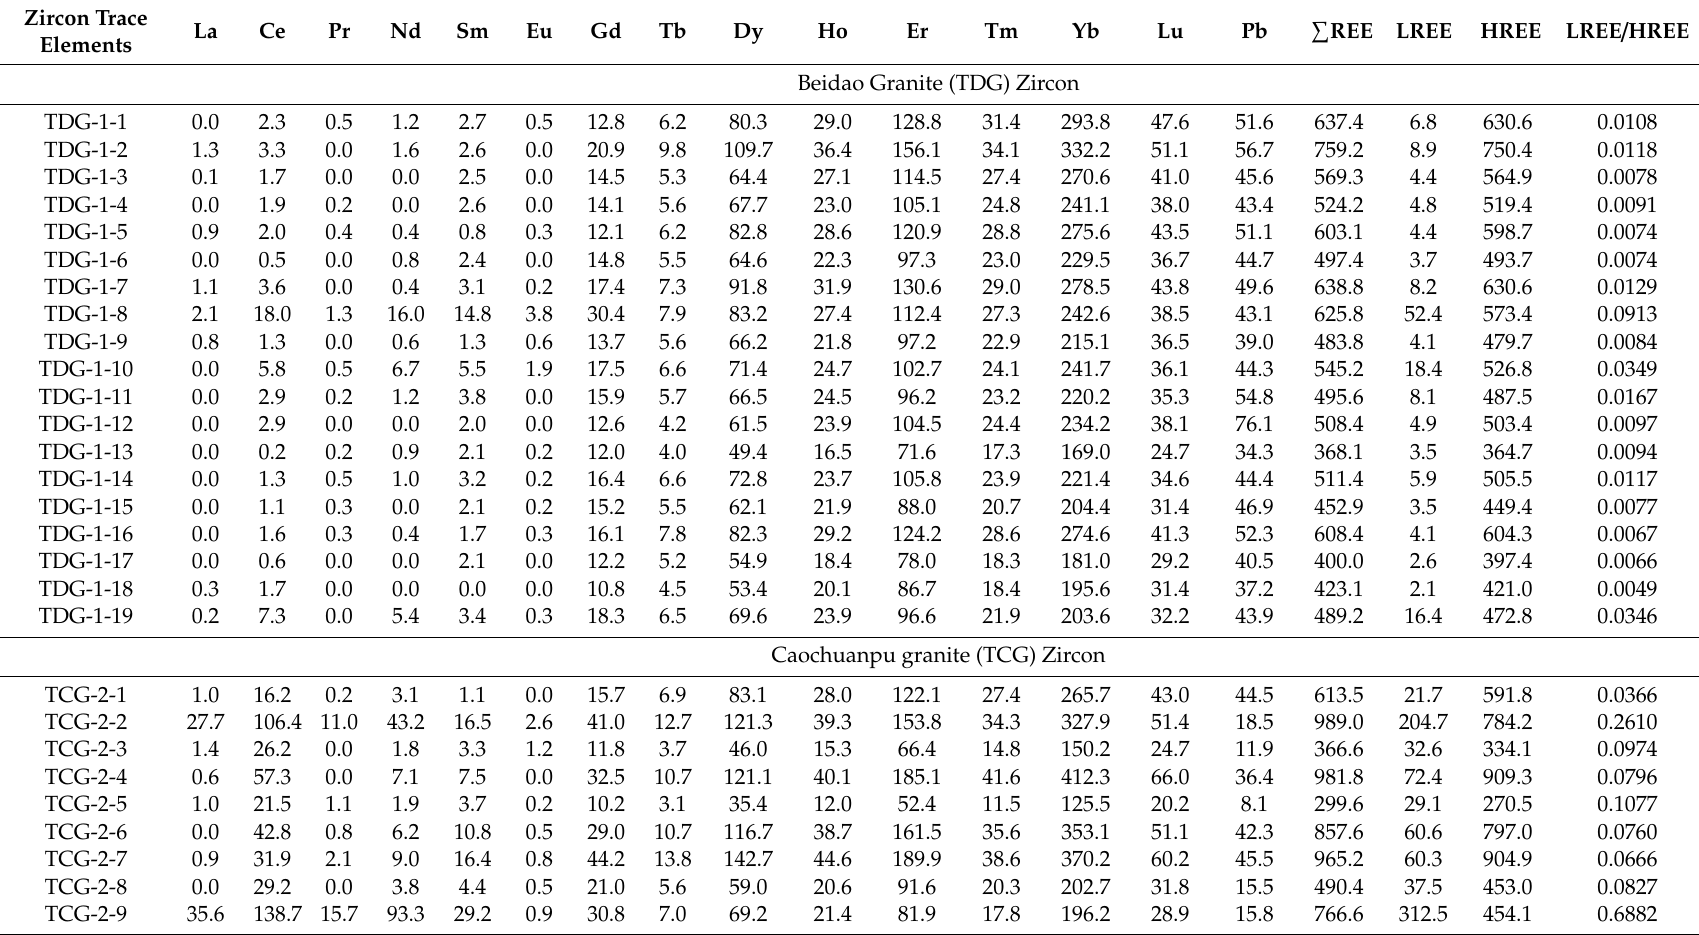
Table 4. The REE and other elements results (in ppm) for the analyzed zircons from the Tianshui granitoids. Zircon